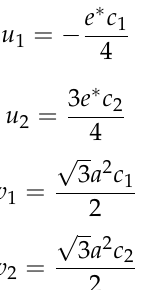
Table 1. Experimentally obtained lattice parameters for various wurtzites along with Born effective charges and P sp values which were obtained both experimentally and theoretically.